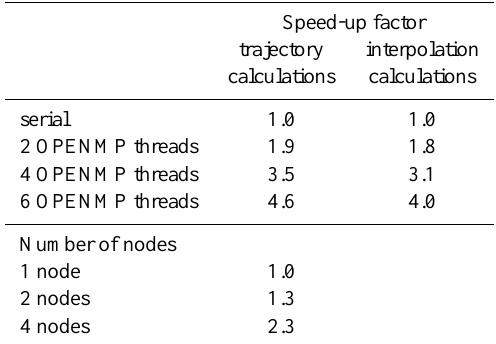
Table 2. Speed factors expected on the trajectory and interpolation calculations using different number of OPENMP threads, and on the trajectory calculations for different number of nodes using MPI threads in hybrid mode. The total speed-up factor in hybrid mode can be calculated by multiplying the speed factors for OPENMP and MPI. See the text for further